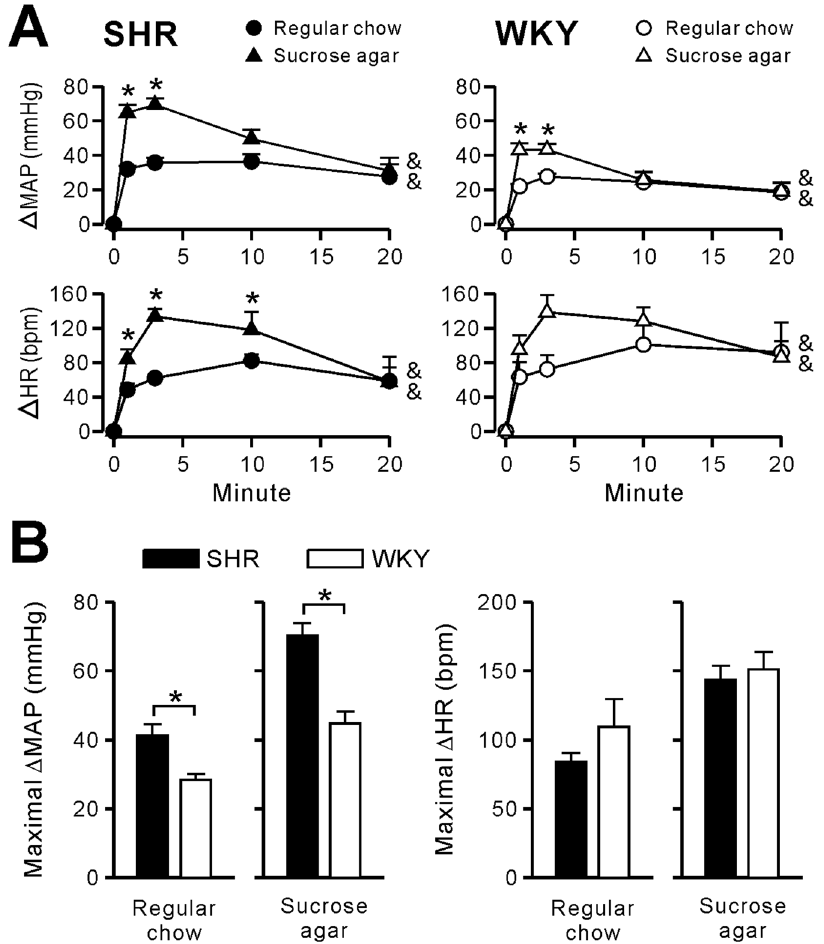
Figure 2. Changes in the mean arterial pressure (MAP) and heart rate (HR) in response to consumption of regular chow or sucrose agar in spontaneously hypertensive rats (SHR) and Wistar Kyoto rats (WKY). Panel A demonstrates the time courses of mean changes in the MAP ( Δ MAP) and HR ( Δ HR) in SHR (plots on the left) and WKY (plots on the right) after initiating consumption of either regular chow or sucrose agar. An ampersand “&” indicates a significant main effect of each treatment over time on the Δ MAP or Δ HR within each group, as determined by a one-factor repeated-measures ANOVA with the Bonferroni post-hoc correction. There were significant interactions between time and treatment for the Δ MAP in SHR and WKY, and for the Δ HR in SHR. A star “ * ” indicates a significant difference between regular chow- and sucrose agar-treated groups at the indicated time points, as determined by a post-hoc paired t -test. Data are expressed as the mean ± SEM from eight SHR and six WKY. Panel B shows the maximal Δ MAP and maximal Δ HR in response to consumption of either regular chow or sucrose agar in SHR and WKY. Data are expressed as the mean ± SEM from the same experimental groups shown in panel A. A star “ * ” indicates a significant difference between SHR and WKY, as determined by Student’s t -test. bpm, beats per